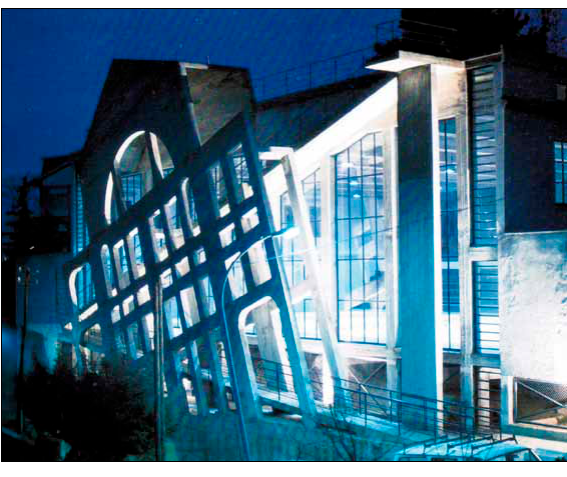
fig. 4. Gym in Paliano,